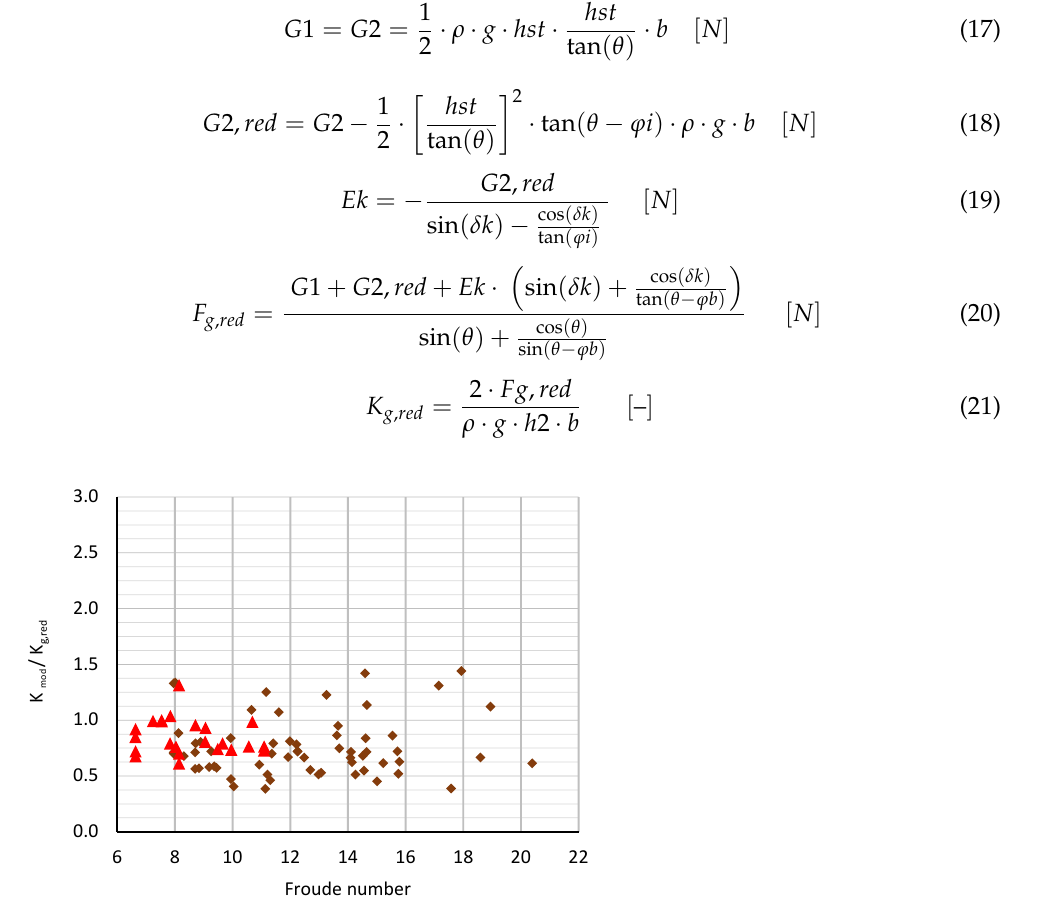
Figure 19. Earth pressure coefficients K mod / K g,red for the mixture and the sand depending on the Froude number.